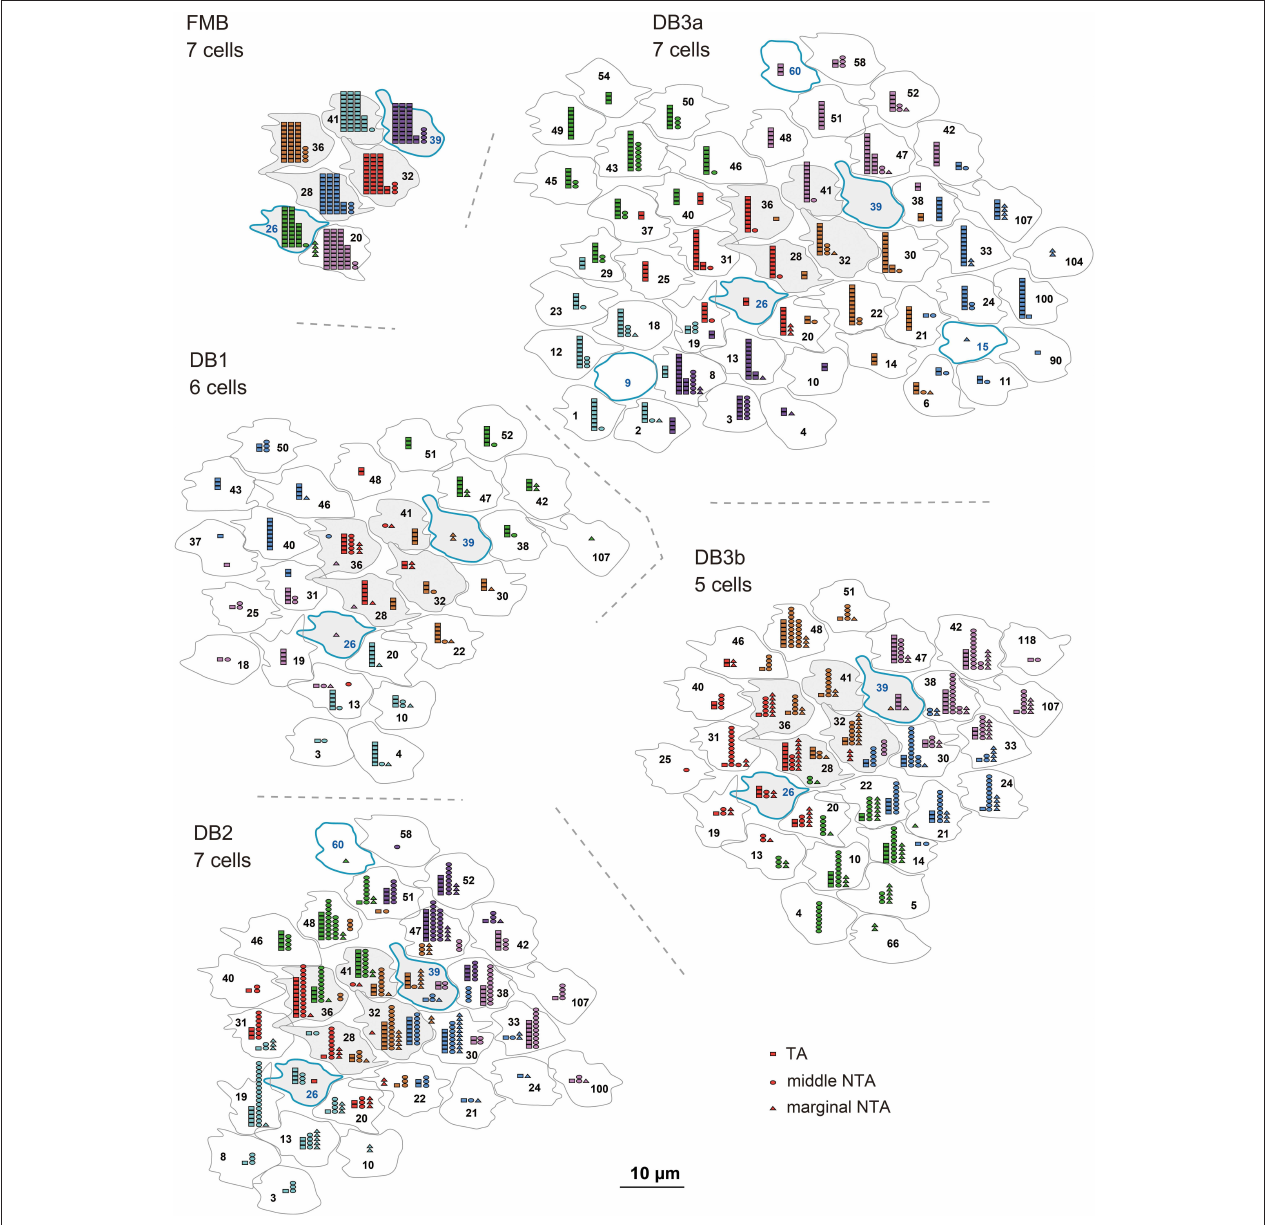
FIGURE 5 | Abundance of each basal synapse class over the entire cone area for each OFF bipolar cell type. A group of OFF bipolar cells of the same type form basal synapses (TA in rectangles, middle NTA in ellipses, and marginal NTA in triangles) with a layer of cone pedicles. The first five members of each DB type are designated by the same colors as in Figure 2 . Six central pedicles (26, 28, 32, 36, 39, and 41) are designated in gray for